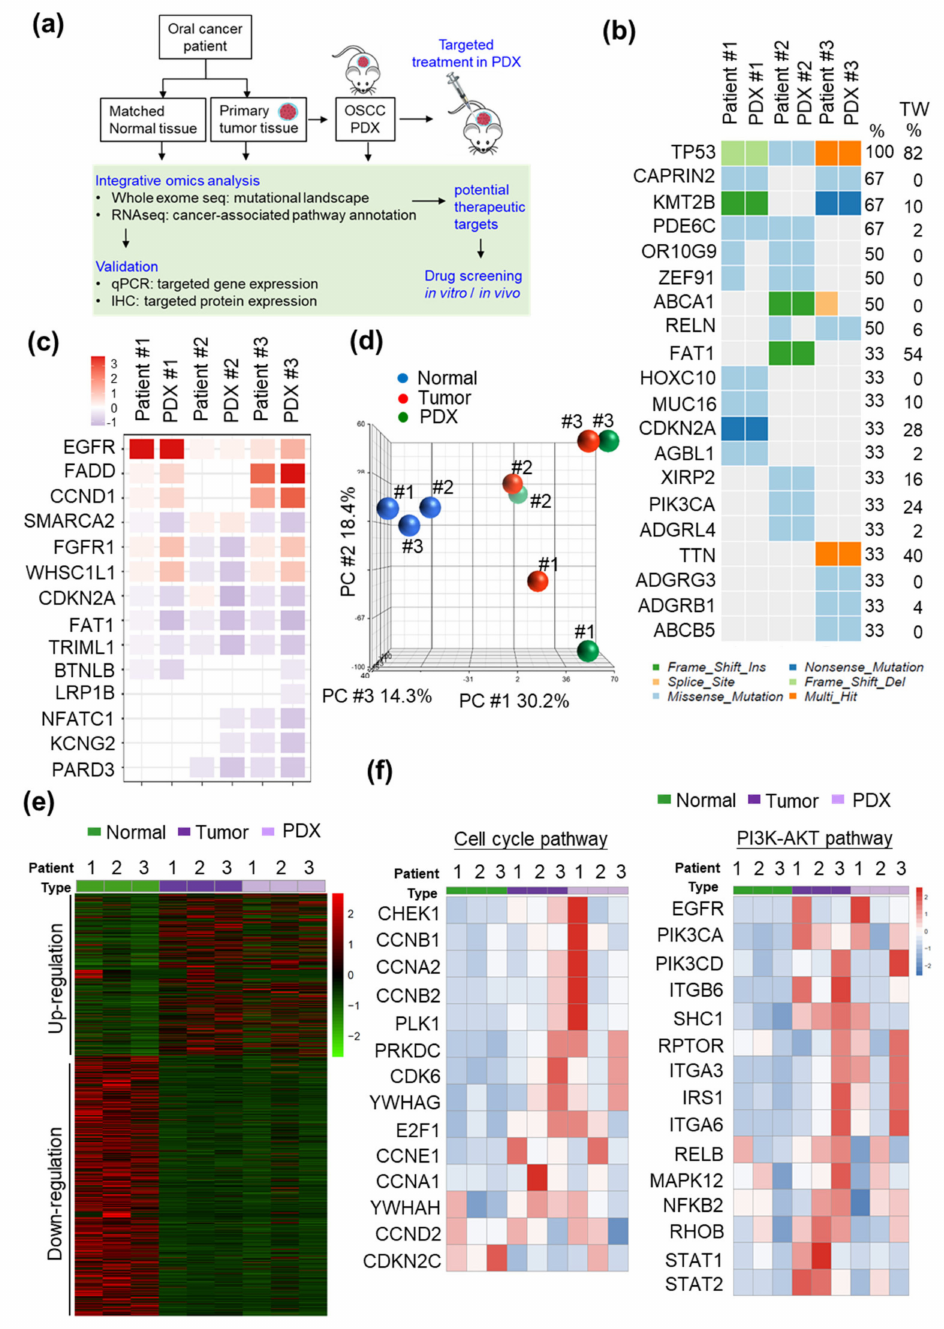
Figure 1. Integrated genomic and transcriptomic analysis of OSCC PDXs. ( a ) Workflow for the integrated genomic characterization and evaluation of the antitumor e ffi cacy of potential inhibitors in OSCC. ( b ) A heatmap of the genomic mutational landscape of the three patients and paired PDXs was generated from the whole-exome sequencing data. The right column shows the mutation frequency of individual genes in the 50 OSCC—Taiwan samples. (c) Heatmap representation of the copy number variations in the patients and paired PDXs. ( d ) PCA of the transcriptome datasets for nine samples. ( e ) Heatmap of the di ff erentially regulated genes (DEGs) in OSCC patients and PDXs demonstrating separation of the expression profiles of normal and tumor tissues. ( f ) Heat maps showing the di ff erentially regulated genes involved in the cell cycle pathway (left panel) and PI3K-AKT pathway (right panel). The signaling intensities for genes are standardized for visualization, and the expression levels are Z-scored. Z-scores were calculated as Z = (X - µ x ) / σ x , where X represents the individual raw expression value, µ x represents the mean raw expression value for the genes across di ff erent sample types, and σ x is the standard deviation associated with µ x